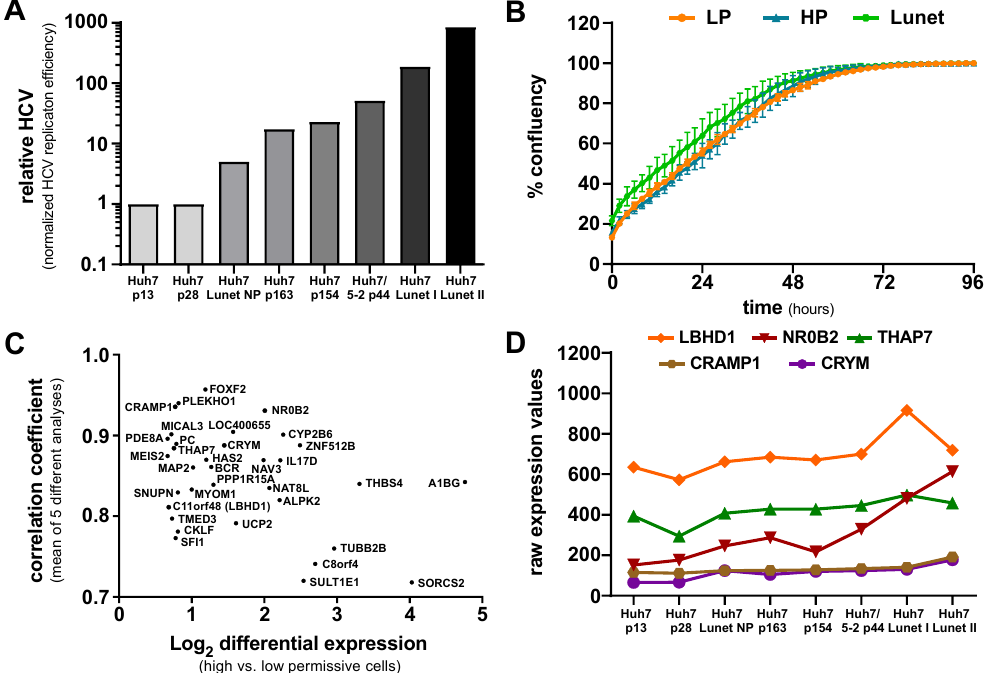
Figure 1. Gene expression profiling and statistical analysis revealed potential HCV permissiveness determining factors. ( A ) HCV (gt1b) replication e ffi ciency di ff ers up to 1000-fold in di ff erent